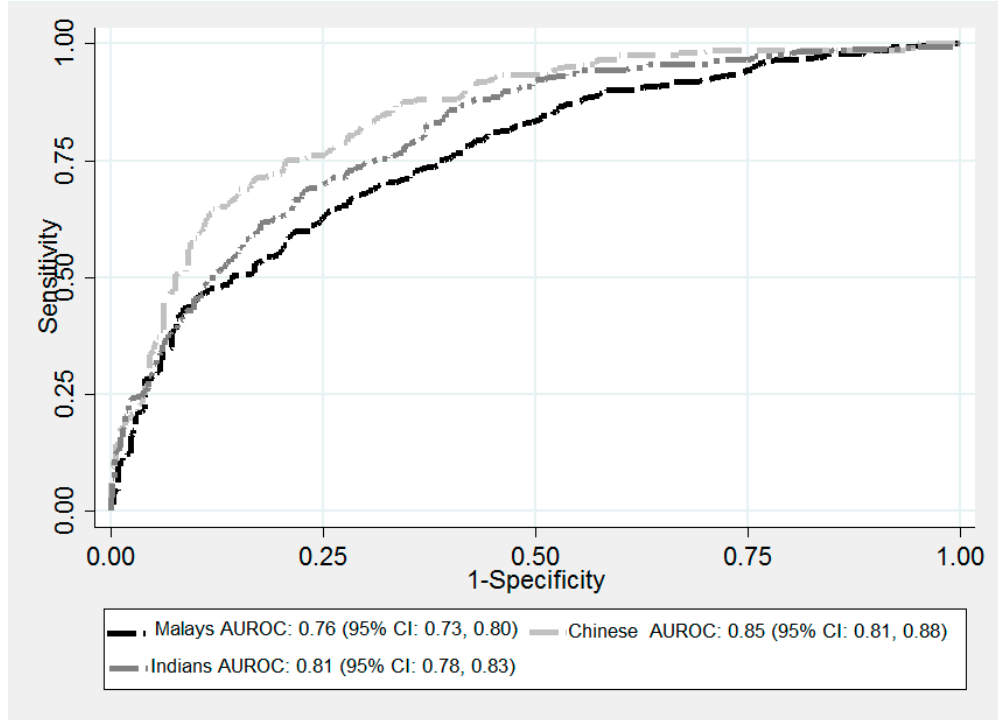
Figure 1. Receiver operating characteristic (ROC) curves with 95% CI for each Malaysian ancestral group based on complete-case analyses (n = 2247). AUC for combined group: 0.80 (0.78, 0.82).